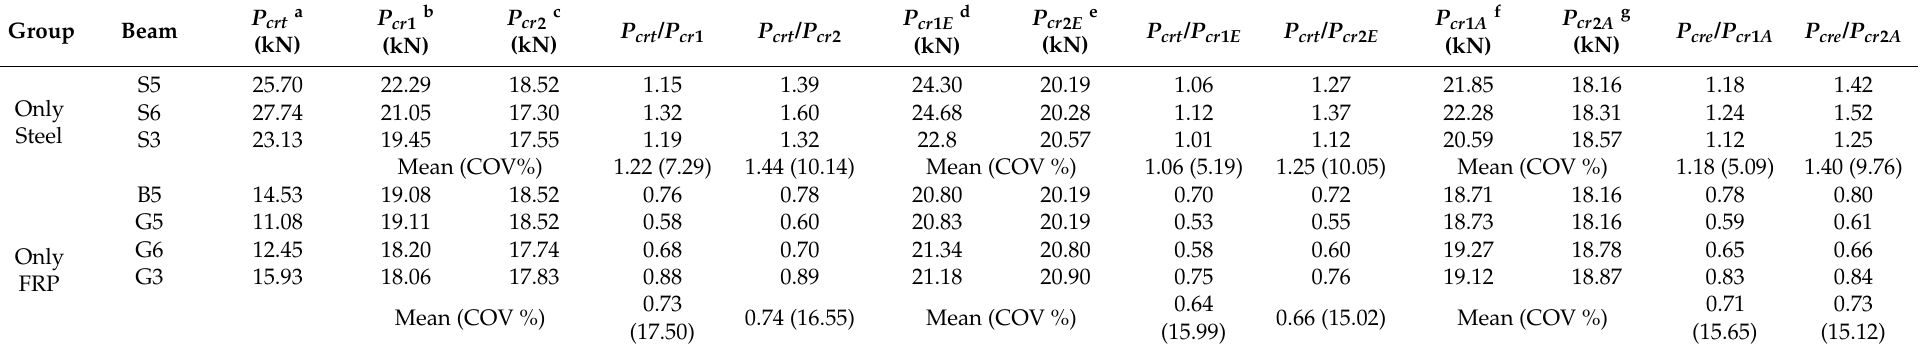
Table 2. Experimental and estimated cracking load values of RC specimens with only steel or FRP reinforcement.